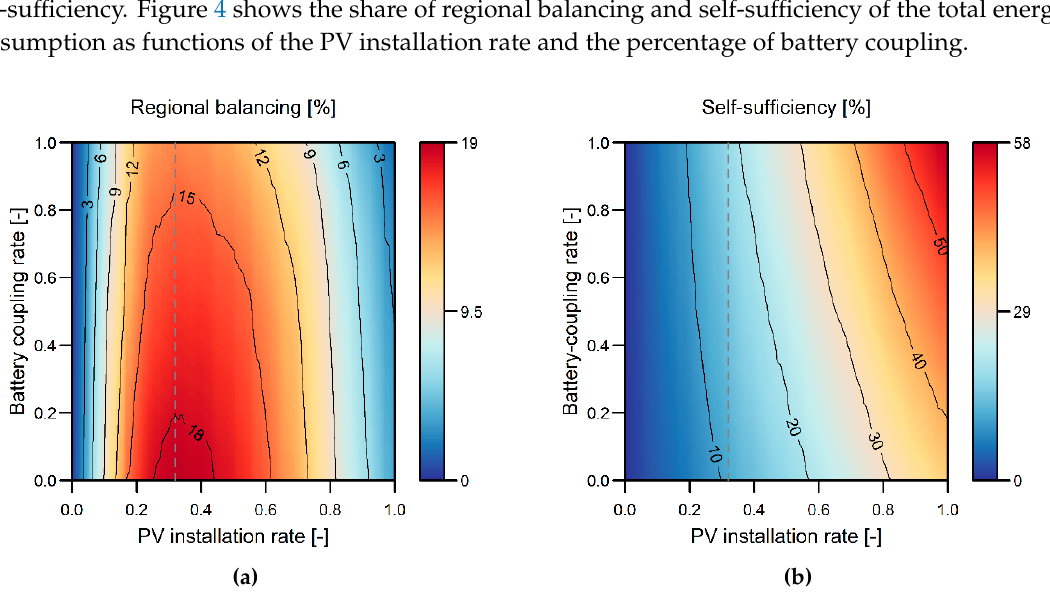
Figure 4. ( a ) Regional balancing and ( b ) self-sufficiency for different PV installation and battery-coupling rates as percentage of consumption (with the PV installation rate of 32% in dashed grey).